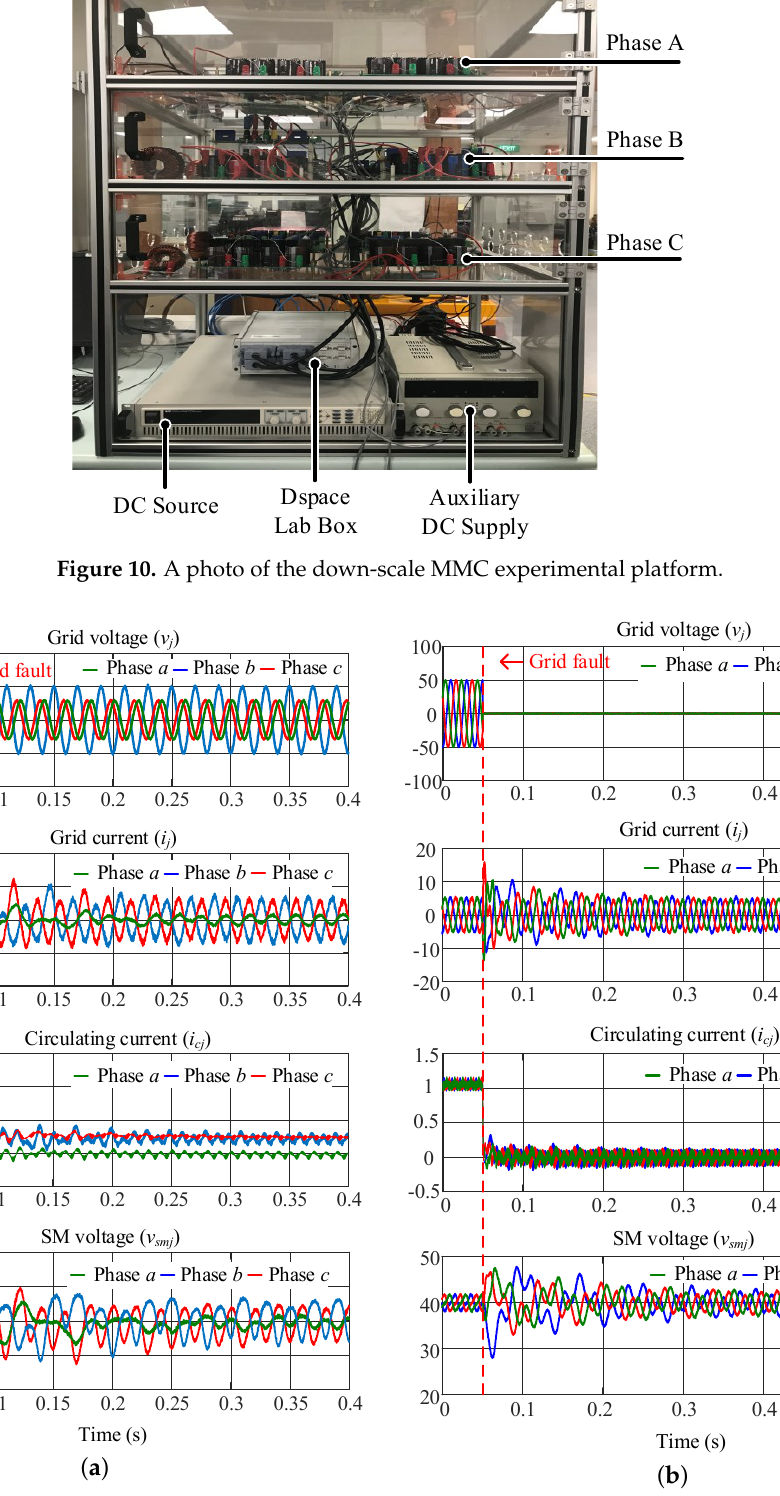
Figure 11. The experiment waveform of the MMC platform under different grid faults: ( a ) single-line-to-ground condition and ( b ) three-phase short-circuit